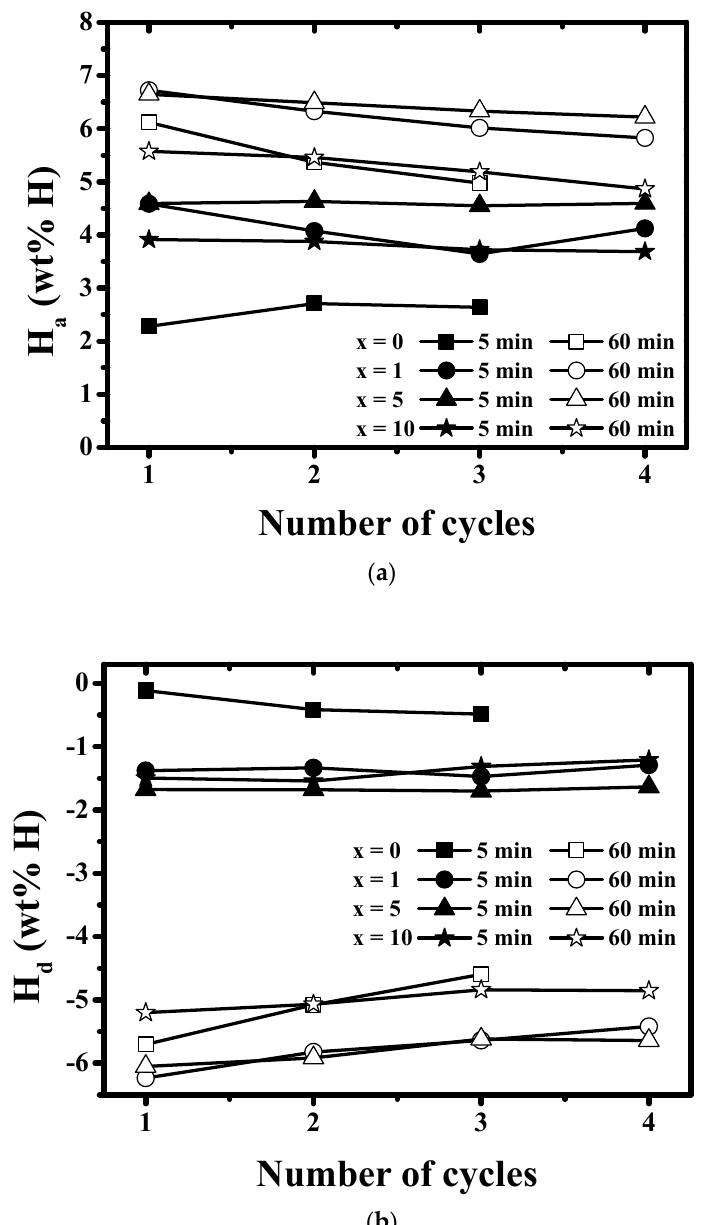
Figure 8. Variations of ( a ) H a values for 5 min and 60 min at 593 K under 12 bar H 2 and ( b ) H d values for 5 min and 60 min at 593 K under 1.0 bar H 2 with the number of cycles for Mg-xMgH 2 -1.25Ni-1.25TaF 5 -1.25VCl 3 (x = 0, 1, 5, and 10).